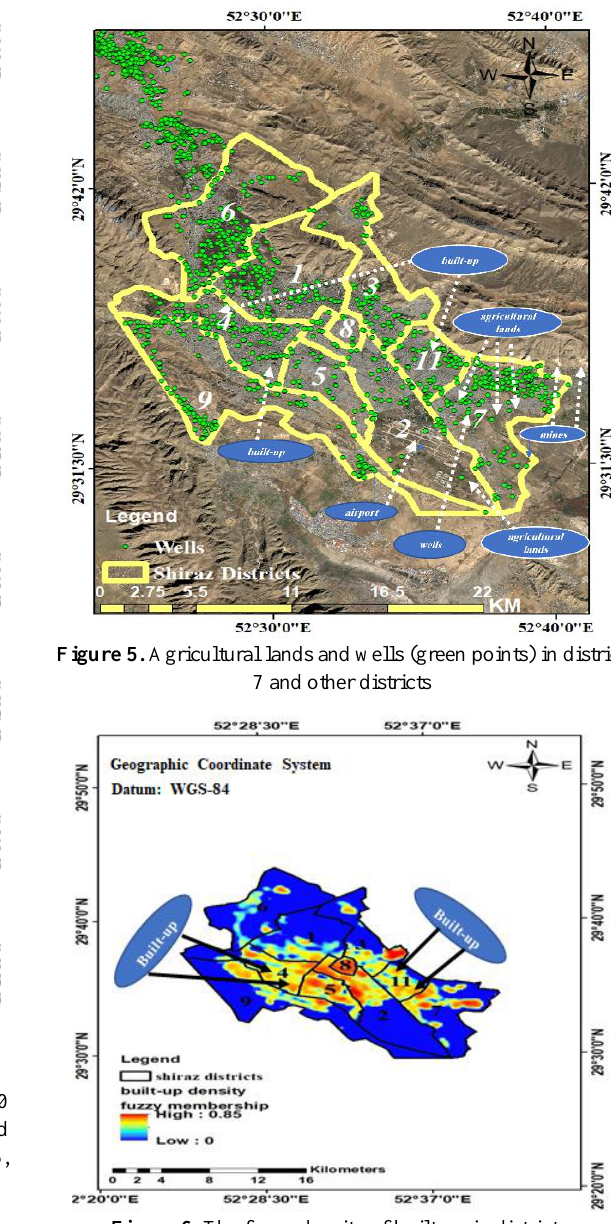
Figure 6. The fuzzy density of built-up in